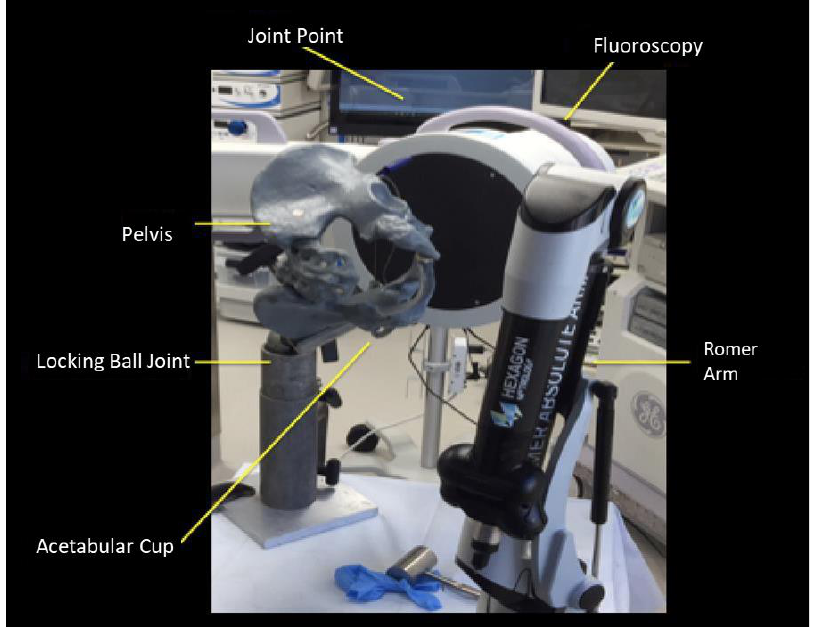
Figure 1. Experimental set-up including pelvis model secured with acetabular component in place, fluoroscopy unit, and the coordinate measure machine Romer Arm.